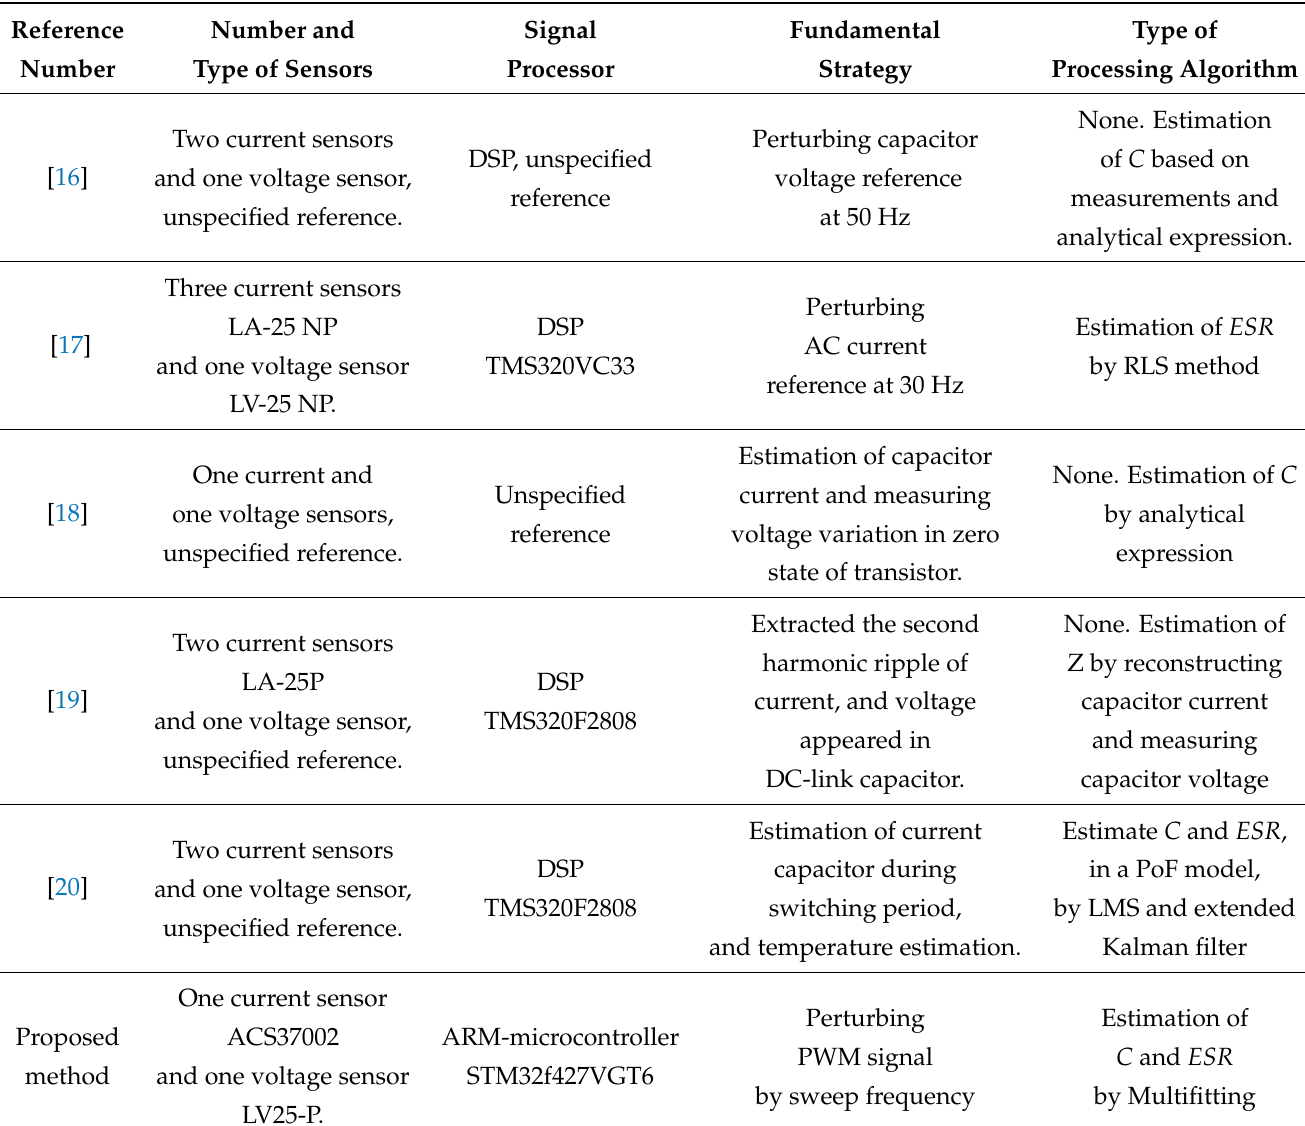
Table 10. Implementation aspects of the methods proposed in